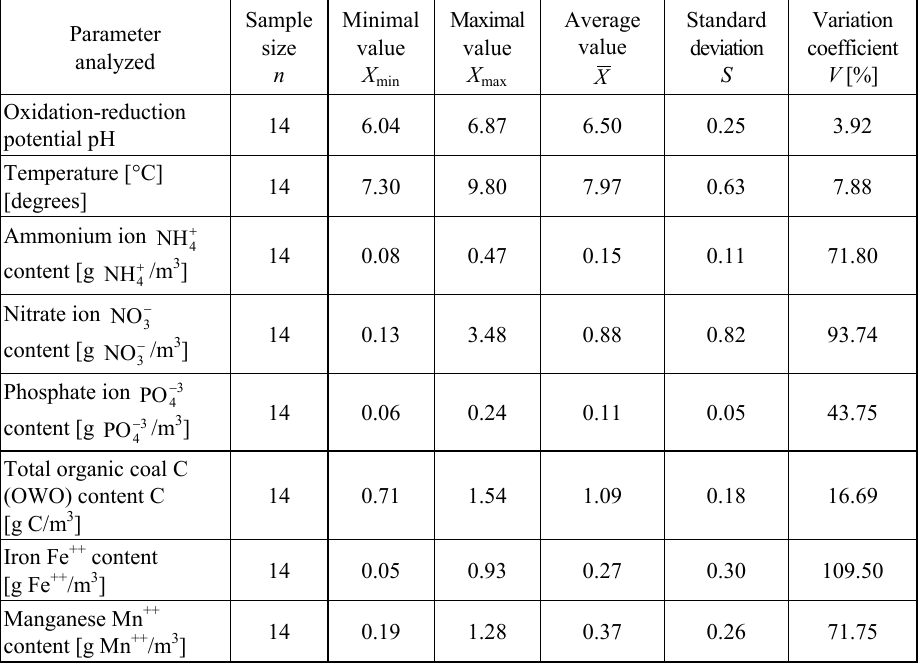
Table 1. Basic statistics of quality parameters of underground water in the intake area in the region of Kłodzko (14 wells) (year 2011)